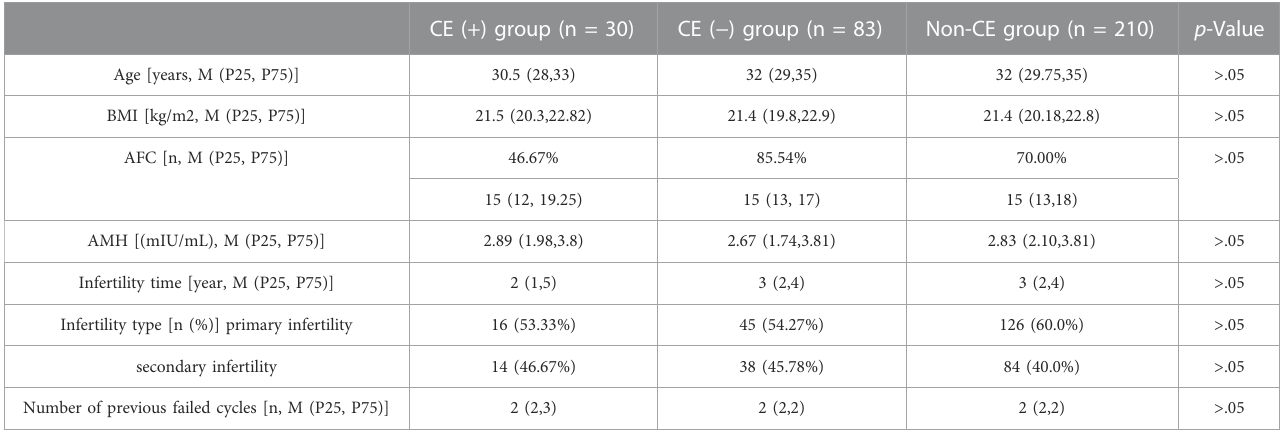
TABLE 1 The baseline characteristics of three groups.